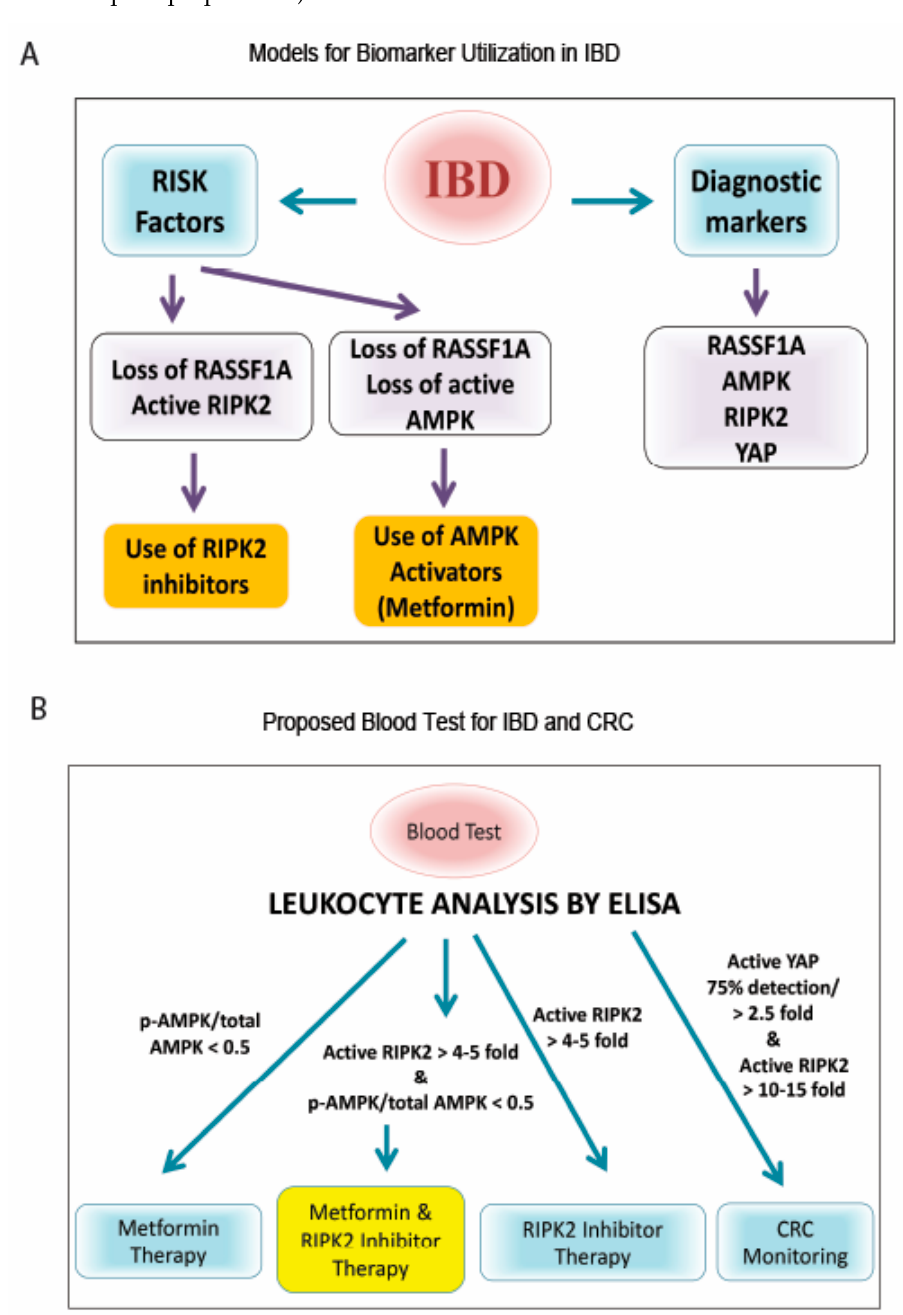
Figure 8. Models for biomarker utilization to monitor and treat IBD. ( A ) Flowchart of importance of RIPK2/RASSF1A/AMPK. Analysis of RASSF1A, AMPK, and RIPK2 could be used to better understand the molecular status of the patient’s colon and as a therapeutic decision making tool for personalized medicine. ( B ) Proposed blood test for IBD and CRC, based on our case study patient and Figure 7. Whole blood or leukocyte fraction can be obtained and a rapid high throughput ELISA developed, with monoclonal antibodies to ascertain activation levels. The use of an RIPK2 inhibitor and/or AMPK activator (metformin), are two therapeutic options that could benefit IBD patients, based on our